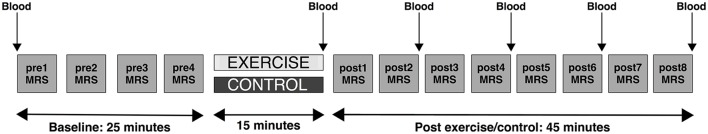
Schematic depicting the study protocol. Participants underwent two 90-min scanning sessions on two different days. On one of the days they received an exercise intervention. On the other day, they received the control intervention (quiet reading). The order of the days were randomly assigned and counterbalanced. In both sessions participants first underwent a series of baseline (pre) scans involving four repeated MRS measurements (depicted by gray squares), came out of the scanner for the intervention, and then returned to the scanner for a series of post-intervention scans (post) involving eight repeated MRS measures. Blood lactate measurements (denoted as “Blood”) were taken from the big toe before the pre-scan, at the end of the intervention period, and after post-MRS measurements 2, 4, 6, and 8.